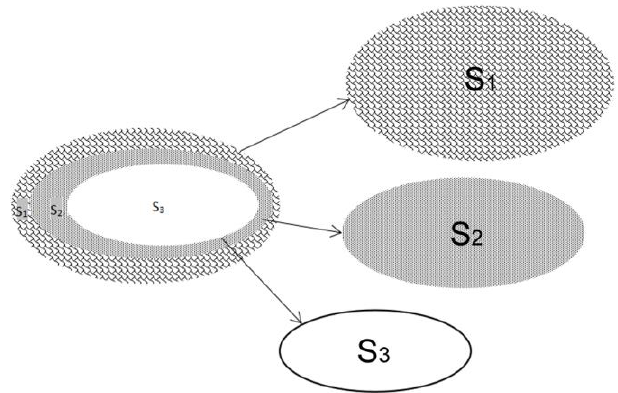
Figure 2. Calculation of the hyperplastic intima. S 1 represents the area of the whole vein; S 2 repre- sents the area of hyperplasia intima plus residual lumen; S 3 represents the area of the residual lu- men. Hyperplastic endothelium was calculated on the original figures according to the following formula: S (%) = 𝑆 2 −𝑆 3 . 𝑆 1 −𝑆 3